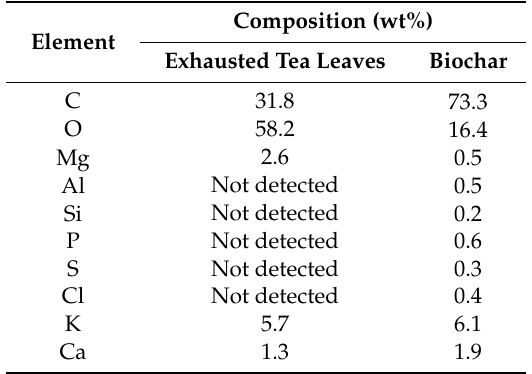
Table 1. Elemental composition of exhausted tea leaves and related